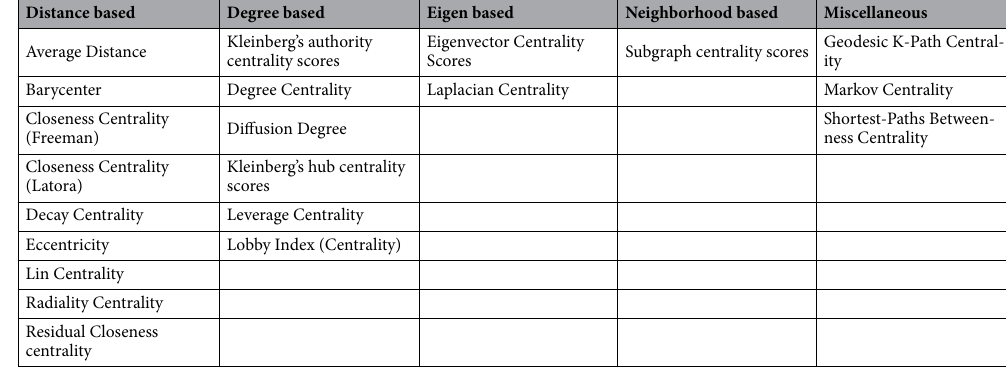
Table 1. Centrality measures. The centrality measures are classified in five groups depending on their logic and formula.